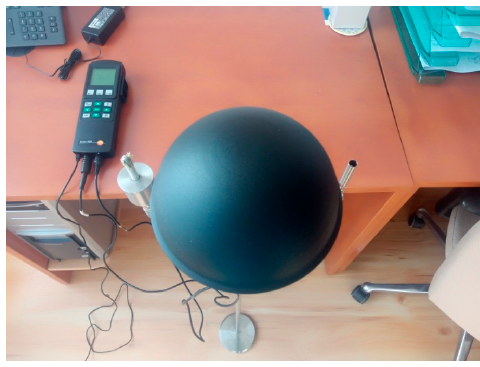
Figure 2. TESTO 400 instrument.